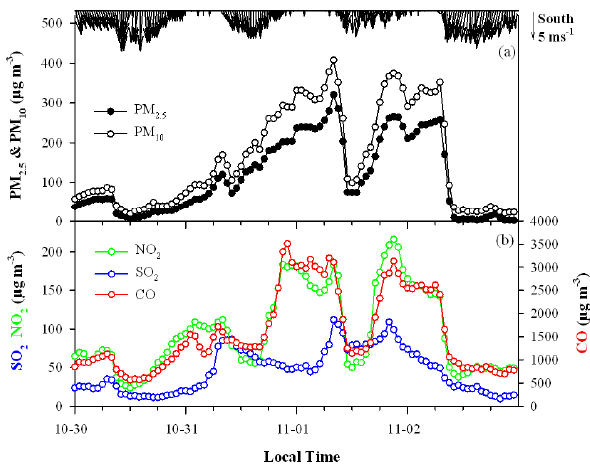
Fig. 7. Time series of hourly (a) particles (PM 2 . 5 , PM 10 ) and (b) pollutant gases (NO 2 , SO 2 , CO) concentrations from 30 October to Figure 7. Time-series of hourly (a) particles (PM 2.5 , PM 10 ) and (b) pollutant gases (NO 2 , SO 2 , CO) concentrations from 2 November